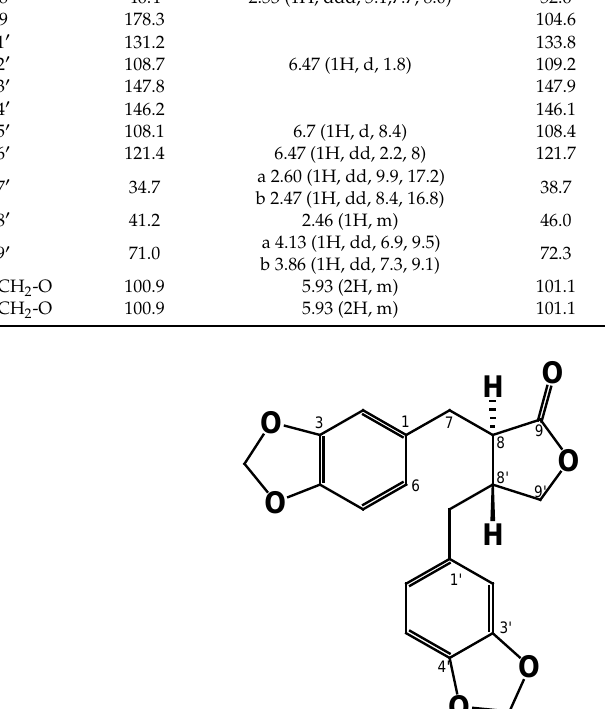
Figure 5. Chemical structure of kaurenoic acid ( 1 ).